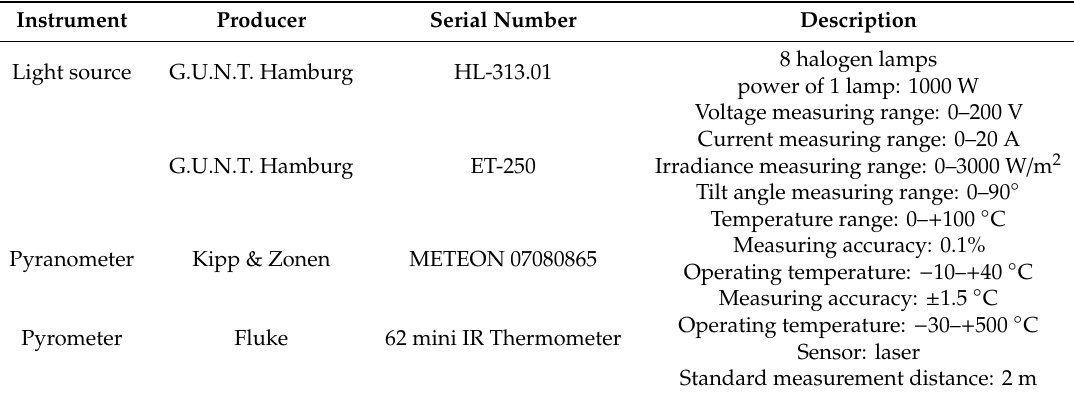
Figure 2. Scheme of the measuring unit in the laboratory hall. Table 2. Technical data of artificial light source as well as gauging devices used for temperature, irradiance, current, and voltage